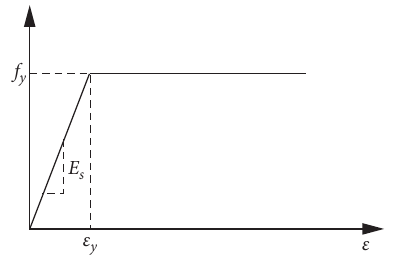
Figure 4: Constitutive behaviors of steel. Table 2: Plastic coefficients of